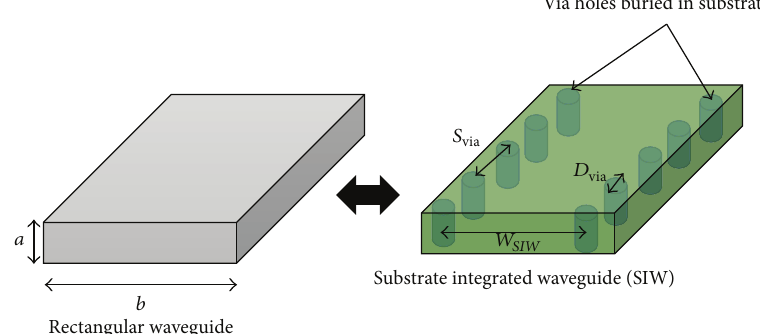
Figure 3: SIW equivalent rectangular